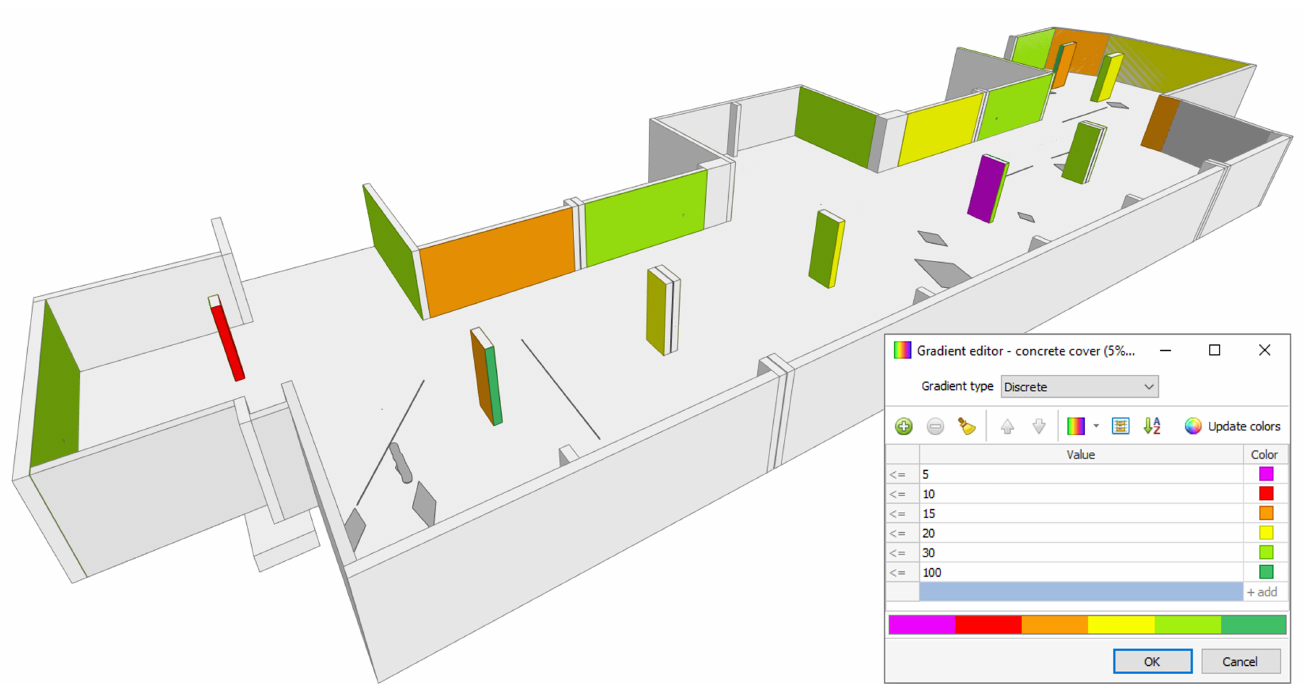
Figure 6. 5% quantile of the concrete cover (front reinforcement layer) in mm color-coded for walls and